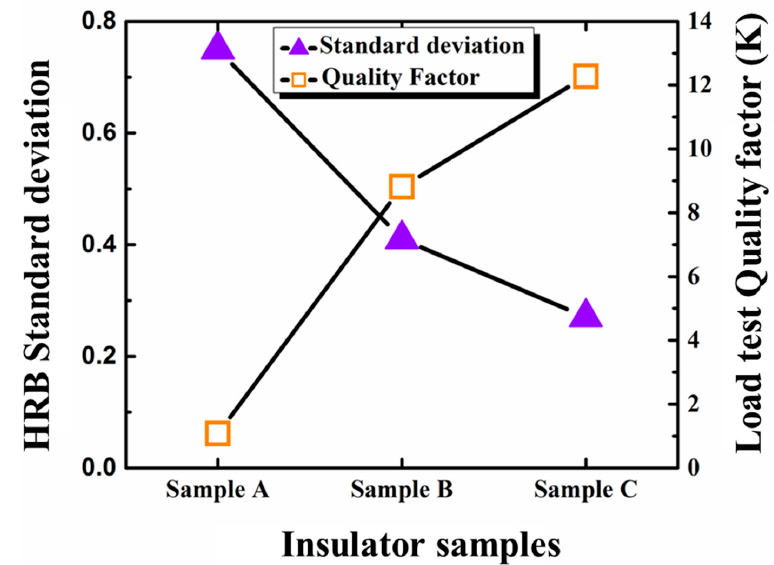
Figure 2. Results of the HRB hardness test and Quality factor of load test on porcelain insulator samples.